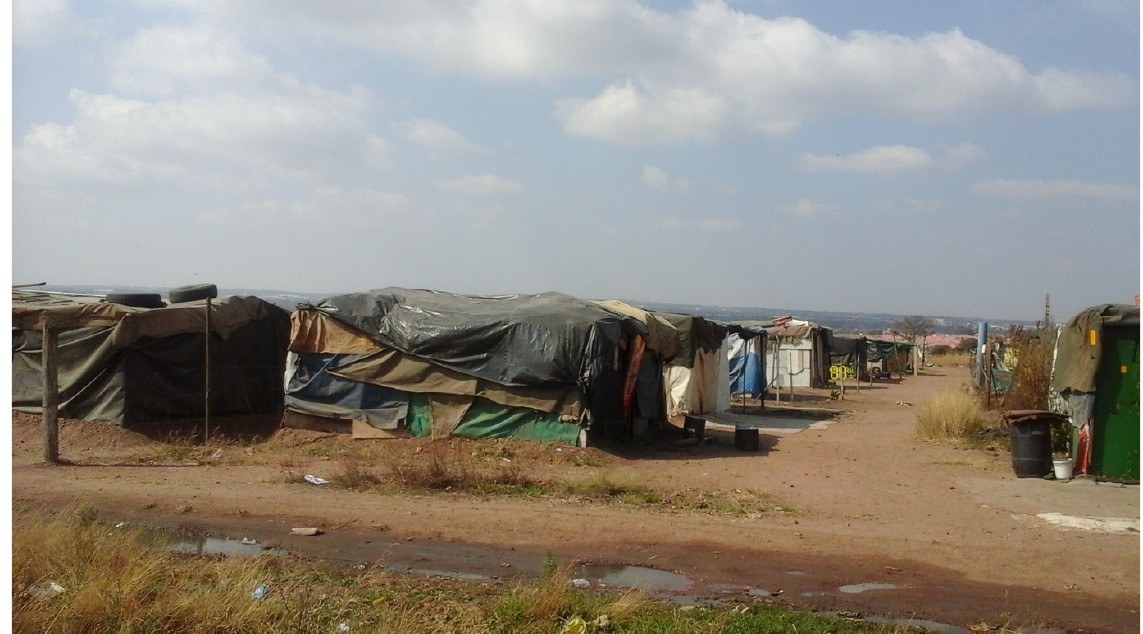
Figure A4. Mohlakaneng Ext106 informal settlement in 2015, Limpopo, South Africa.